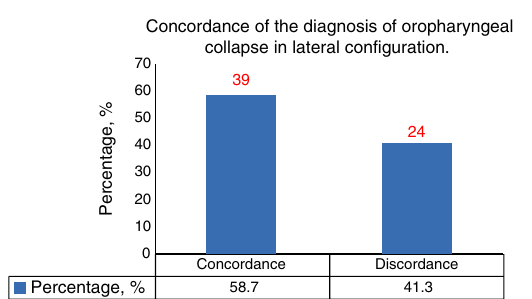
DiscordanceConcordance Percentage, % Concordance of the diagnosis of oropharyngeal col- lapse in lateral configuration.